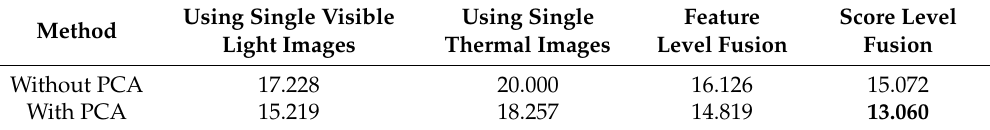
Table 15. The recognition accuracy (EER, %) of recognition system with and without applying